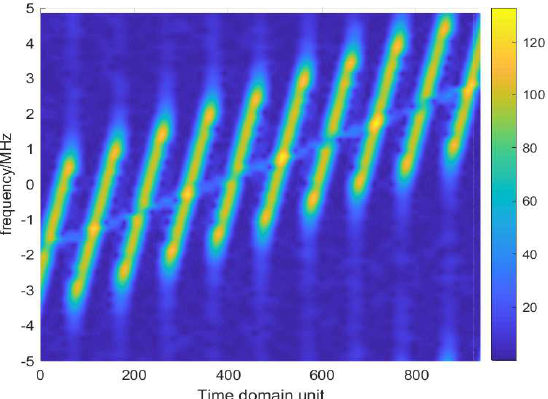
Figure 16. Time-frequency distribution of mixed signal when there is a Doppler frequency.